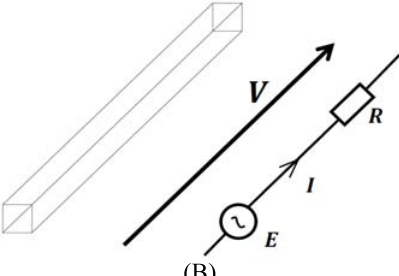
Figure 5: (A) Division of a sane plate into elements; (B) electrical model of one element